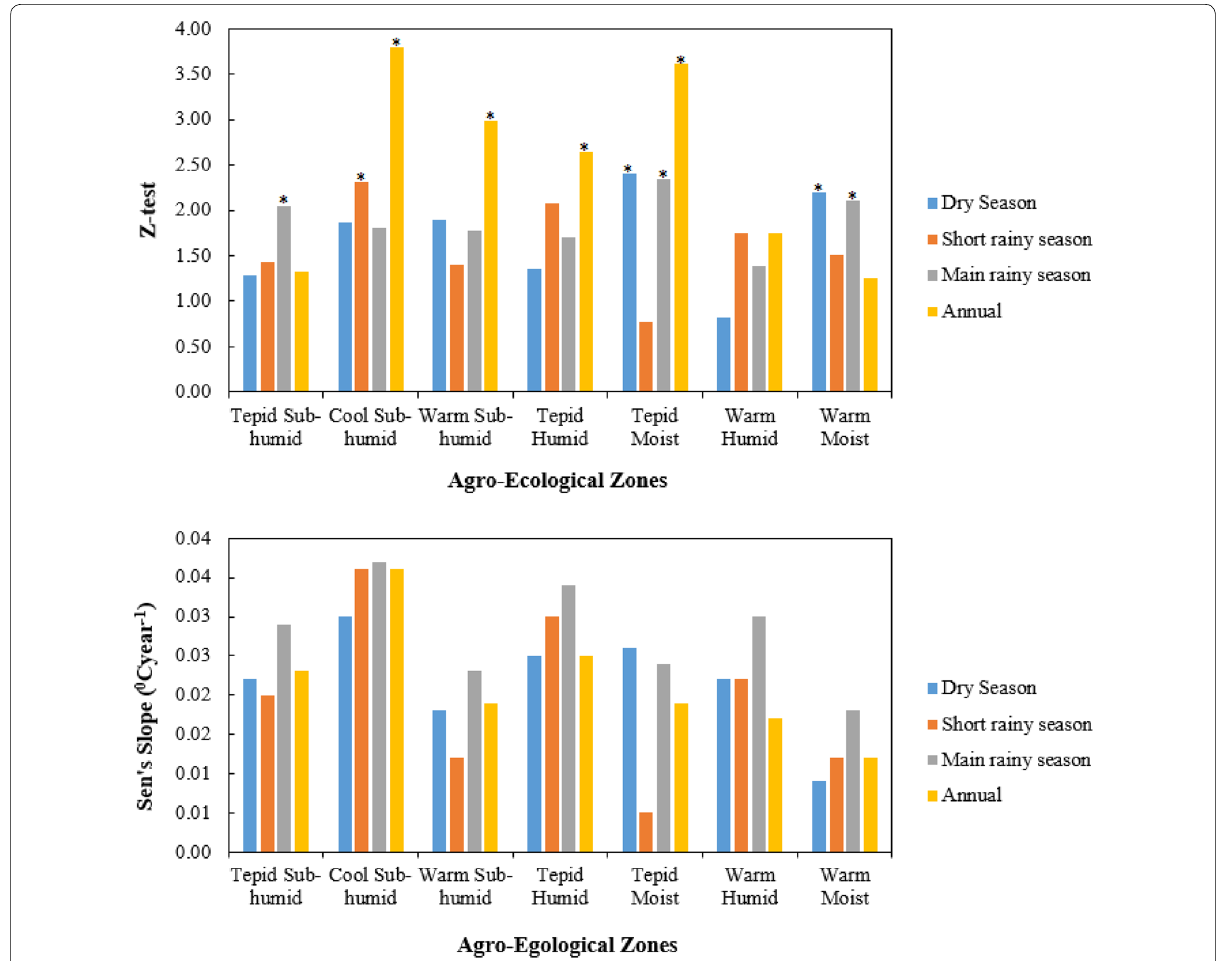
Fig. 4 Z-test (top) and Son’s slope (bottom) of minimum